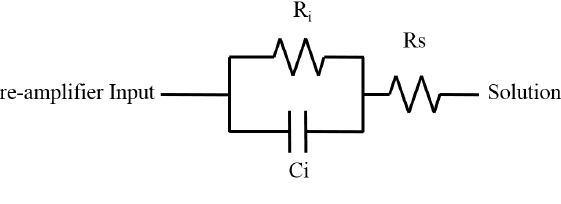
Figure 3. Equivalent circuit model for C4